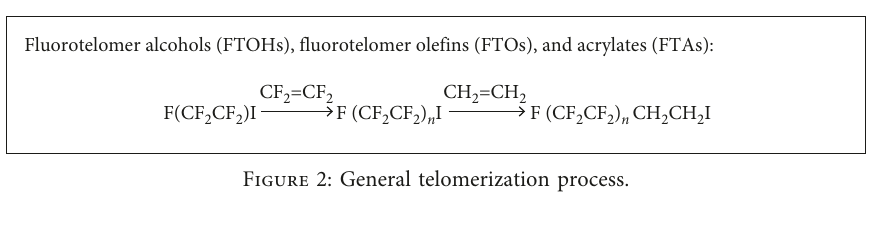
Figure 2: General telomerization